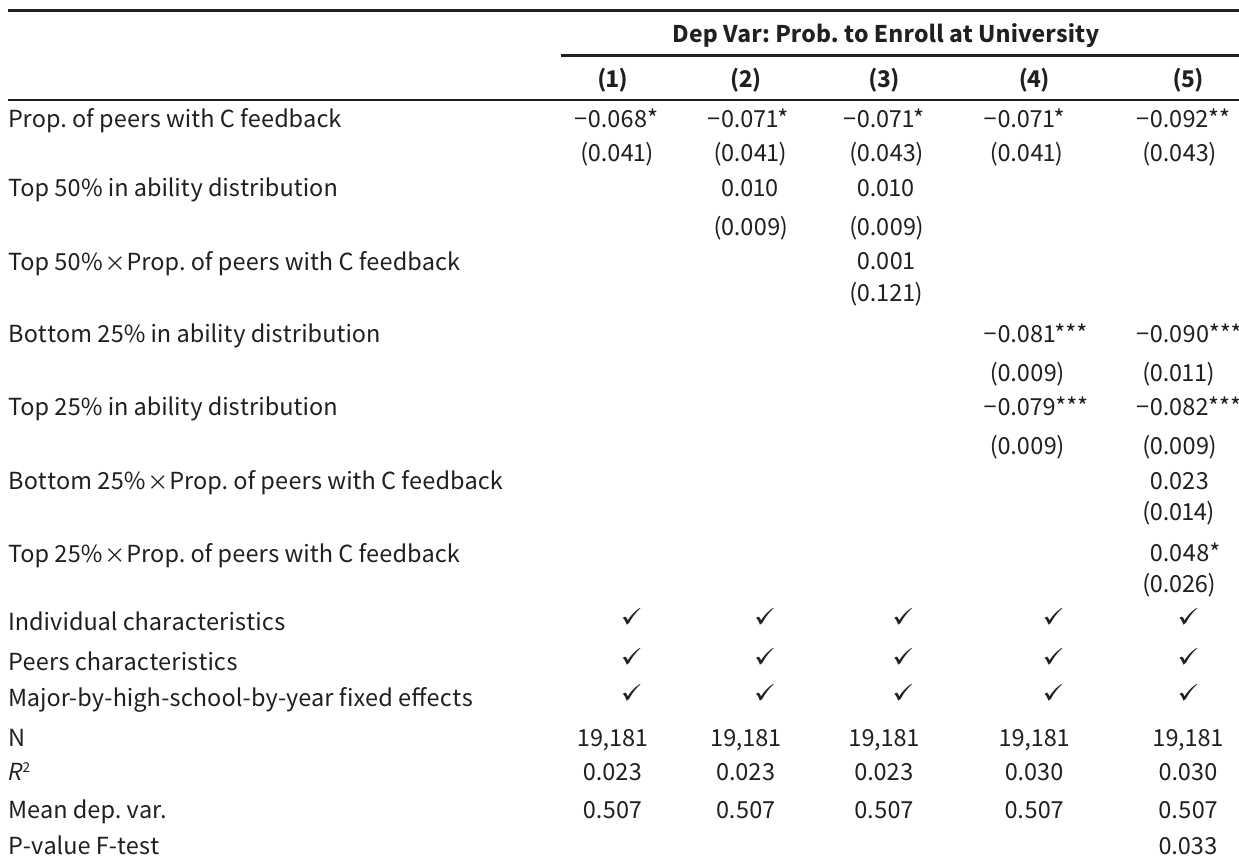
Heterogeneous effects: Regressions by ability level